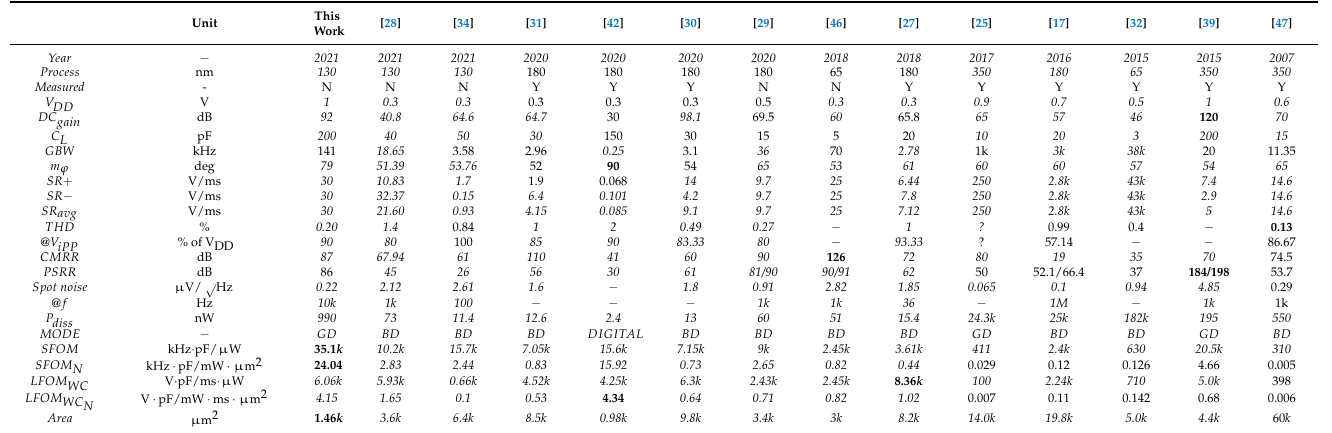
Table 7. Comparison with the literature (best values shown in